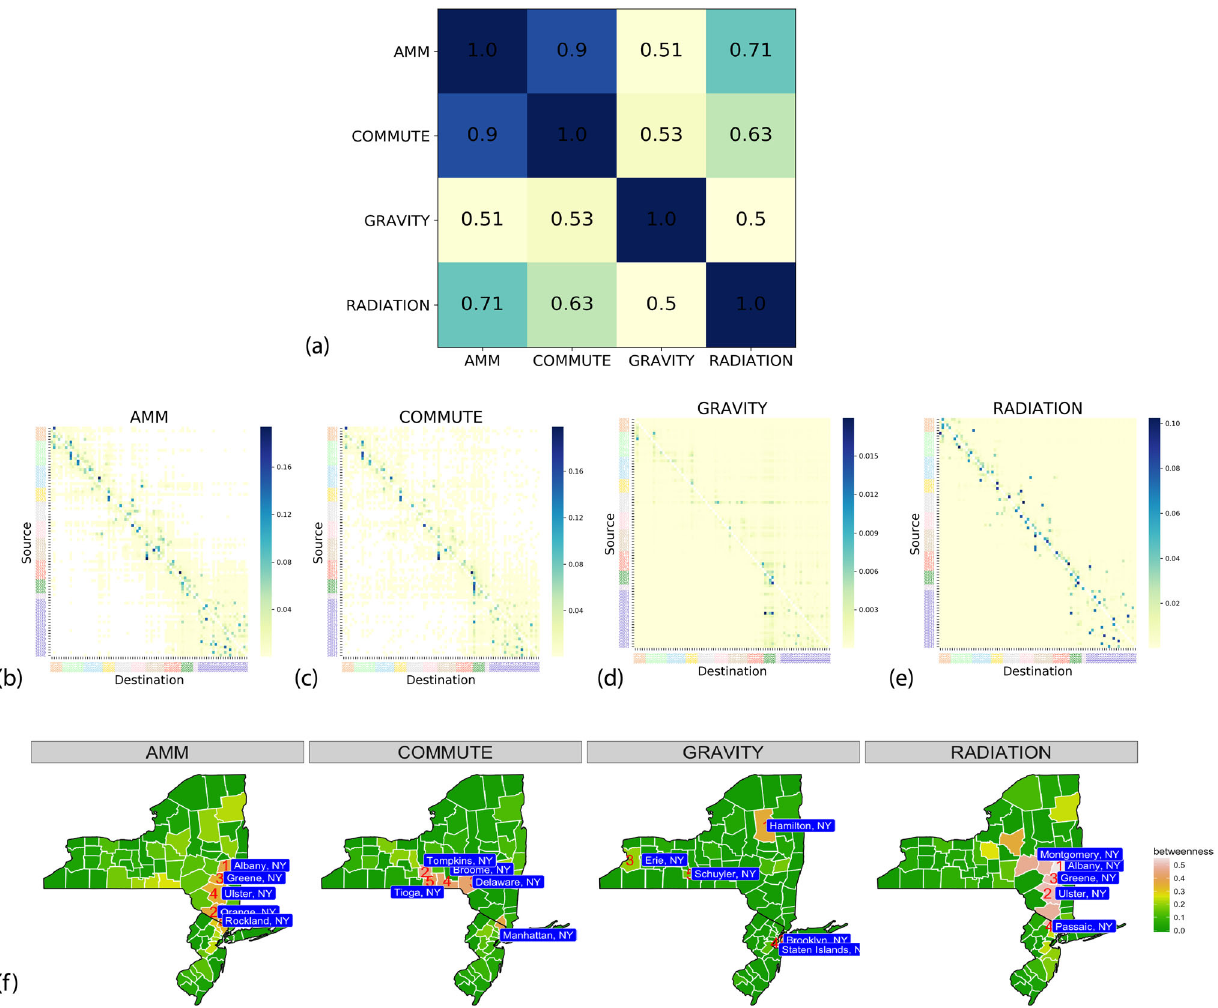
Fig. 3 Structural comparison of the networks. a Correlation between networks. Pearson correlation coef fi cient between the different mobility networks (FIPS-sorted by source and destination). AMM and COMMUTE have a high positive correlation value (0.90), followed by RADIATION model (0.71 with AMM), while GRAVITY has relatively small positive correlation with the other networks. b – e Adjacency fl ow matrices of AMM, COMMUTE, GRAVITY, and RADIATION. Nodes are arranged by spatial proximity. Heatmap color is indicative of normalized fl ow volume (darker color denotes larger fl ow). Note that while AMM and COMMUTE are sparser and seem to be clustered, GRAVITY network, by virtue of its de fi nition, is more homogeneous. More detailed versions of AMM and COMMUTE fl ows are shown in Supplementary Figs. 3 and 4. f Betweenness measures at county level for all four networks. Among the four networks, AMM, and RADIATION models have similar sets of top counties by betweenness, while COMMUTE chooses nearby but distinct counties. These counties are reasonable choices, since they connect rural counties, e.g., Allegany or St. Lawrence or Cape May, to highly urbanized counties like Manhattan or Brooklyn. However, in GRAVITY we failed to identify any such distinct